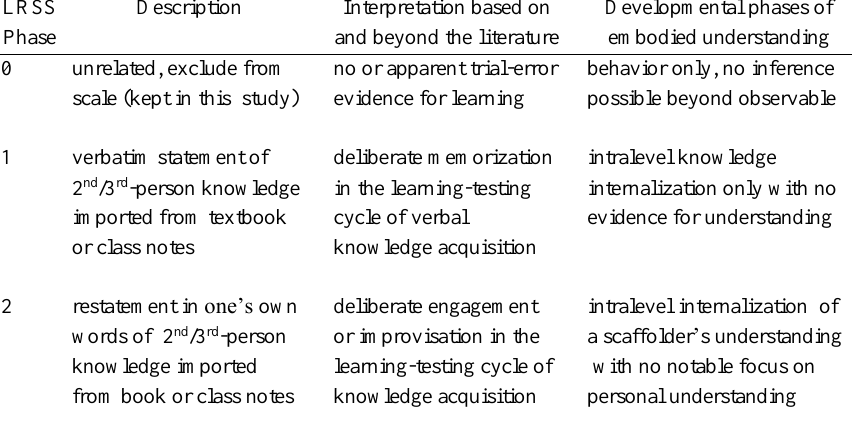
Levels of Revelatory Strikingness Scale (LRSS) Showing Multiple Facets and Phases of (Educational) Development of Biofunctional<>Psychological Understand-ing Spiral that Causes Sustains hindsight Intuition>Revelation<>Reflection